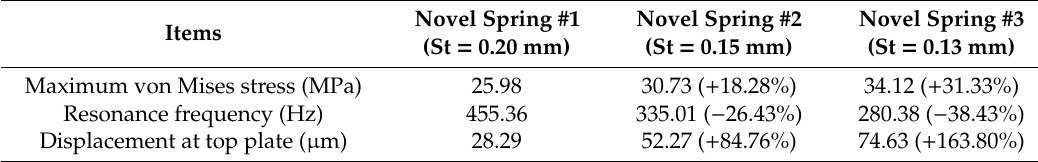
Figure 23. von Mises stress distribution on novel spring with different spring thicknesses. Table 8. Analysis result comparison between different spring thicknesses.